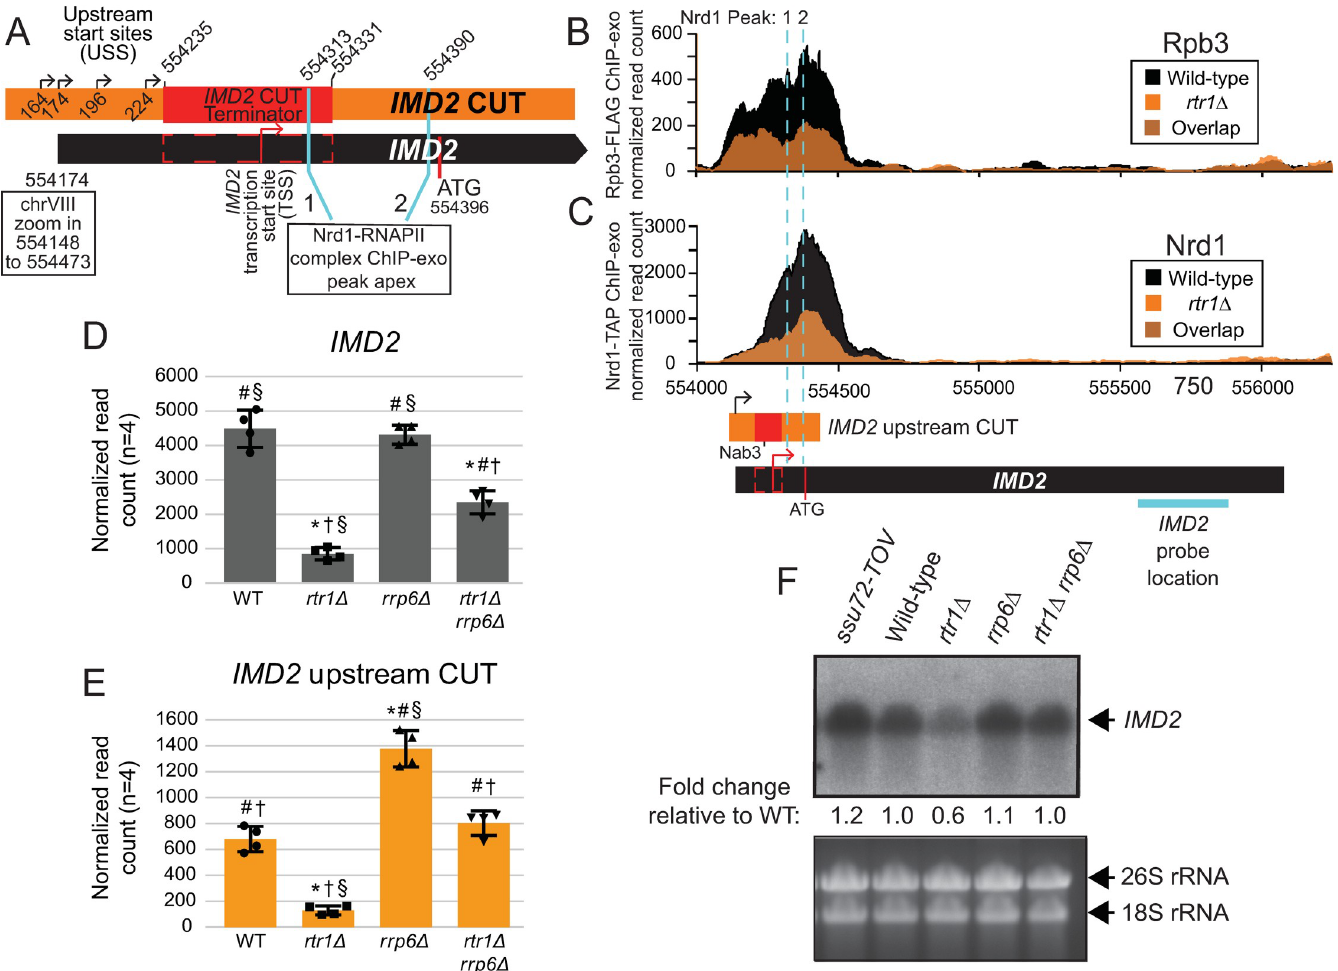
Fig 6. Rtr1 is required for basal IMD2 expression. A) Schematic representation of the IMD2 start sites. Previously defined upstream start sites (USS) are indicated with black arrows with the downstream start site (TSS), preferred in low GTP conditions, indicated with a red arrow [79]. The orange box designates the annotation information for the IMD2 upstream CUT whereas the black box designates the annotation information for the IMD2 mRNA. The red box designates the location of the previously characterized IMD2 terminator region in both A and B [46, 79]. These have been drawn to scale based on each annotation and previously published observations. MACS analysis of Nrd1-RNAPII peaks from the ChIP-exo datasets is indicated with aqua lines. The translation start site is also indicated as a red line. Occupancy of RNAPII (B) and Nrd1 (C) at the IMD2 gene. Data derived from WT cells is in black, and those from the rtr1 Δ strain are in orange. The location and direction of transcription for all analyzed annotations are diagrammed below the graphs, each to scale as in A. D) Expression of the IMD2 mRNA RNA-Seq (n = 4) with FDR values calculated using ANOVA with a Tukey’s multiple comparison test. The symbols designate FDR values � 0.001 as follows: � significantly different from WT, # significantly different from rtr1 Δ , † significantly different from rrp6 Δ , and § significantly different from rtr1 Δ rrp6 Δ . E) Expression of IMD2 upstream CUT by RNA-Seq (n = 4) with statistics performed as indicated for D. F) Northern blot analysis of IMD2 expression in various genotype cells as indicated. The location of the probe used for this northern is indicated by an aqua line under panel